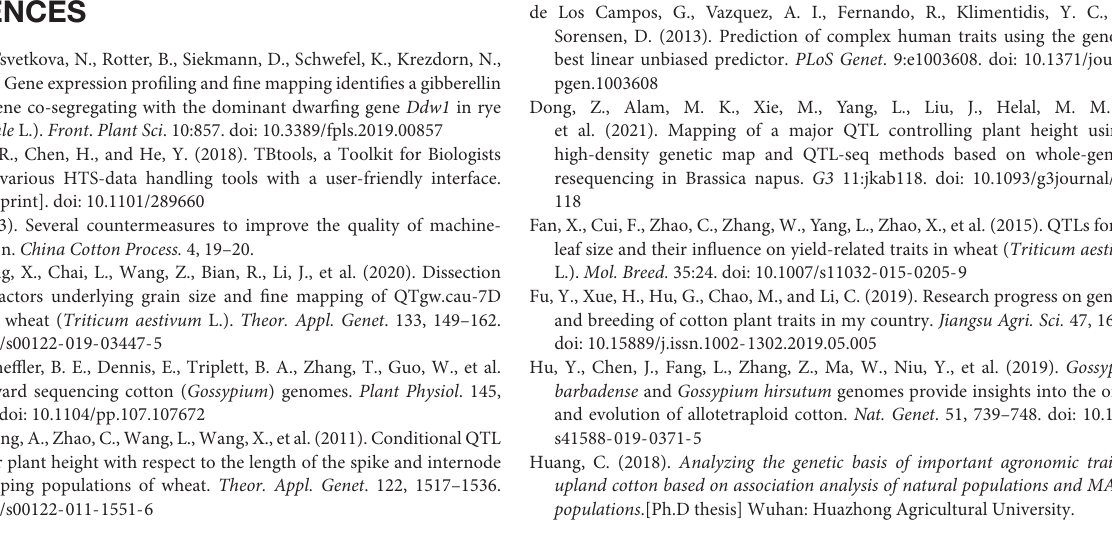
Supplementary Figure 1 | The quantitative trait loci (QTL) allele effect for the qPH-A08-1 , qPH-A11-1 , qPH-D07-1 , qPH-D09-1 and qPH-D13-1 related to PH. (a) Box plots for the qPH-A08-1 related to PH. (b) Box plots for the qPH-A11-1 related to PH. (c) Box plots for the qPH-D07-1 related to PH. (d) Box plots for the qPH-D09-1 related to PH. (e) Box plots for the qPH-D13-1 related to